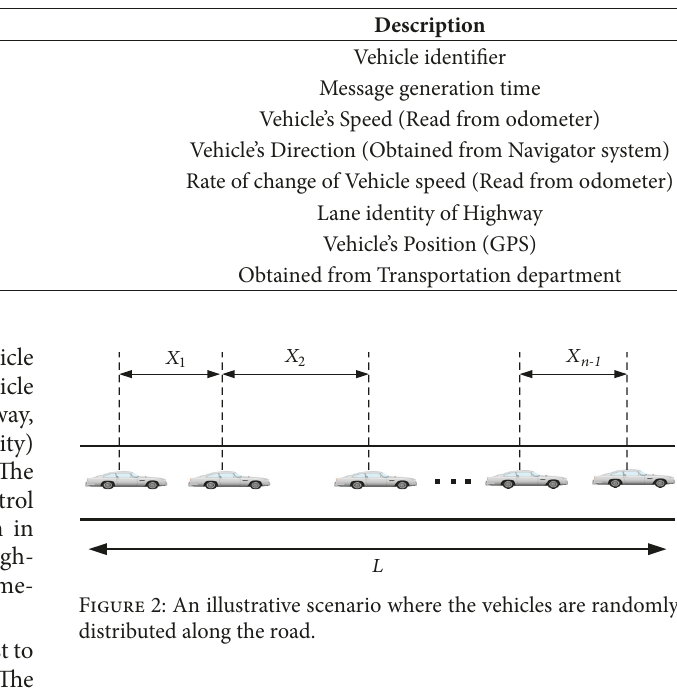
Table 2: Transportation control domain in beacon message.